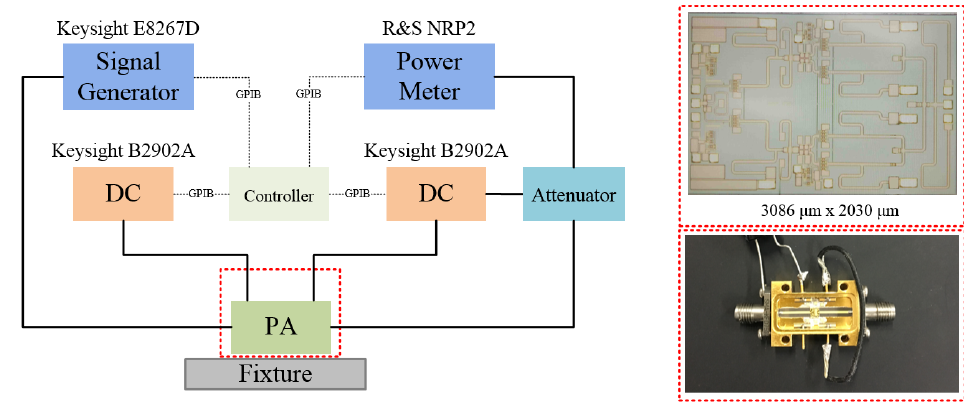
Figure 15. Experimental setup to perform power amplifier (PA) measurements under frequency = 9–15 GHz, V cc = 4.5 V, V B 1 = 1 V, V B 2 = 0.9 V; block diagram (left) of power; the right is the photograph of